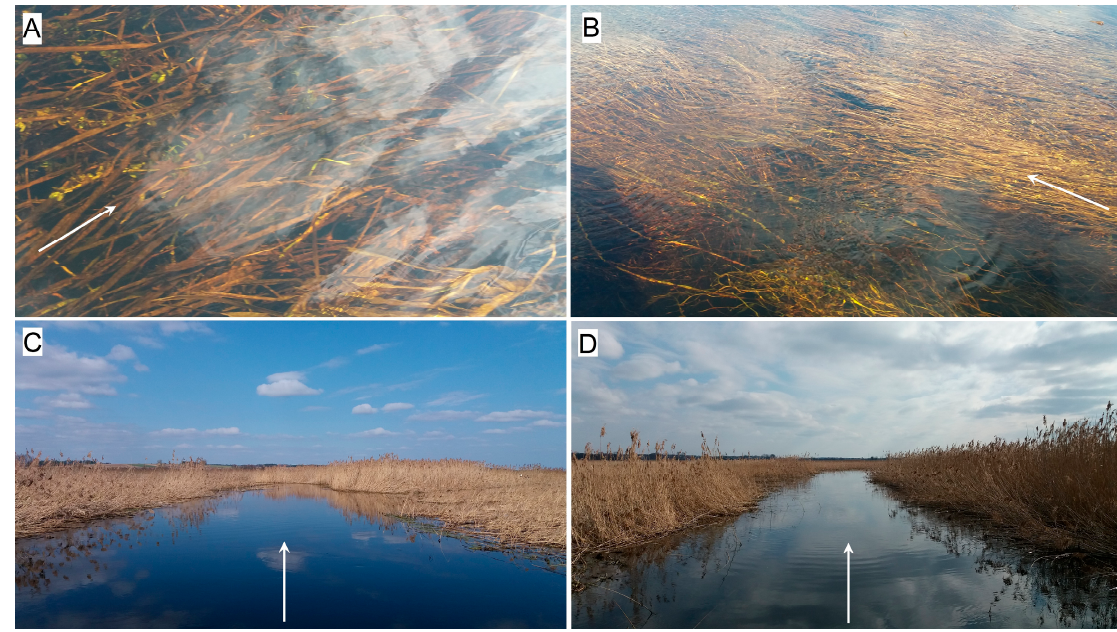
Figure 3. In-stream vegetation presence/absence during winter season in: ( A ) Reach 5; ( B ) Reach 10; ( C ) Reach 19; and ( D ) Reach 22. White arrows indicate the direction of flow.